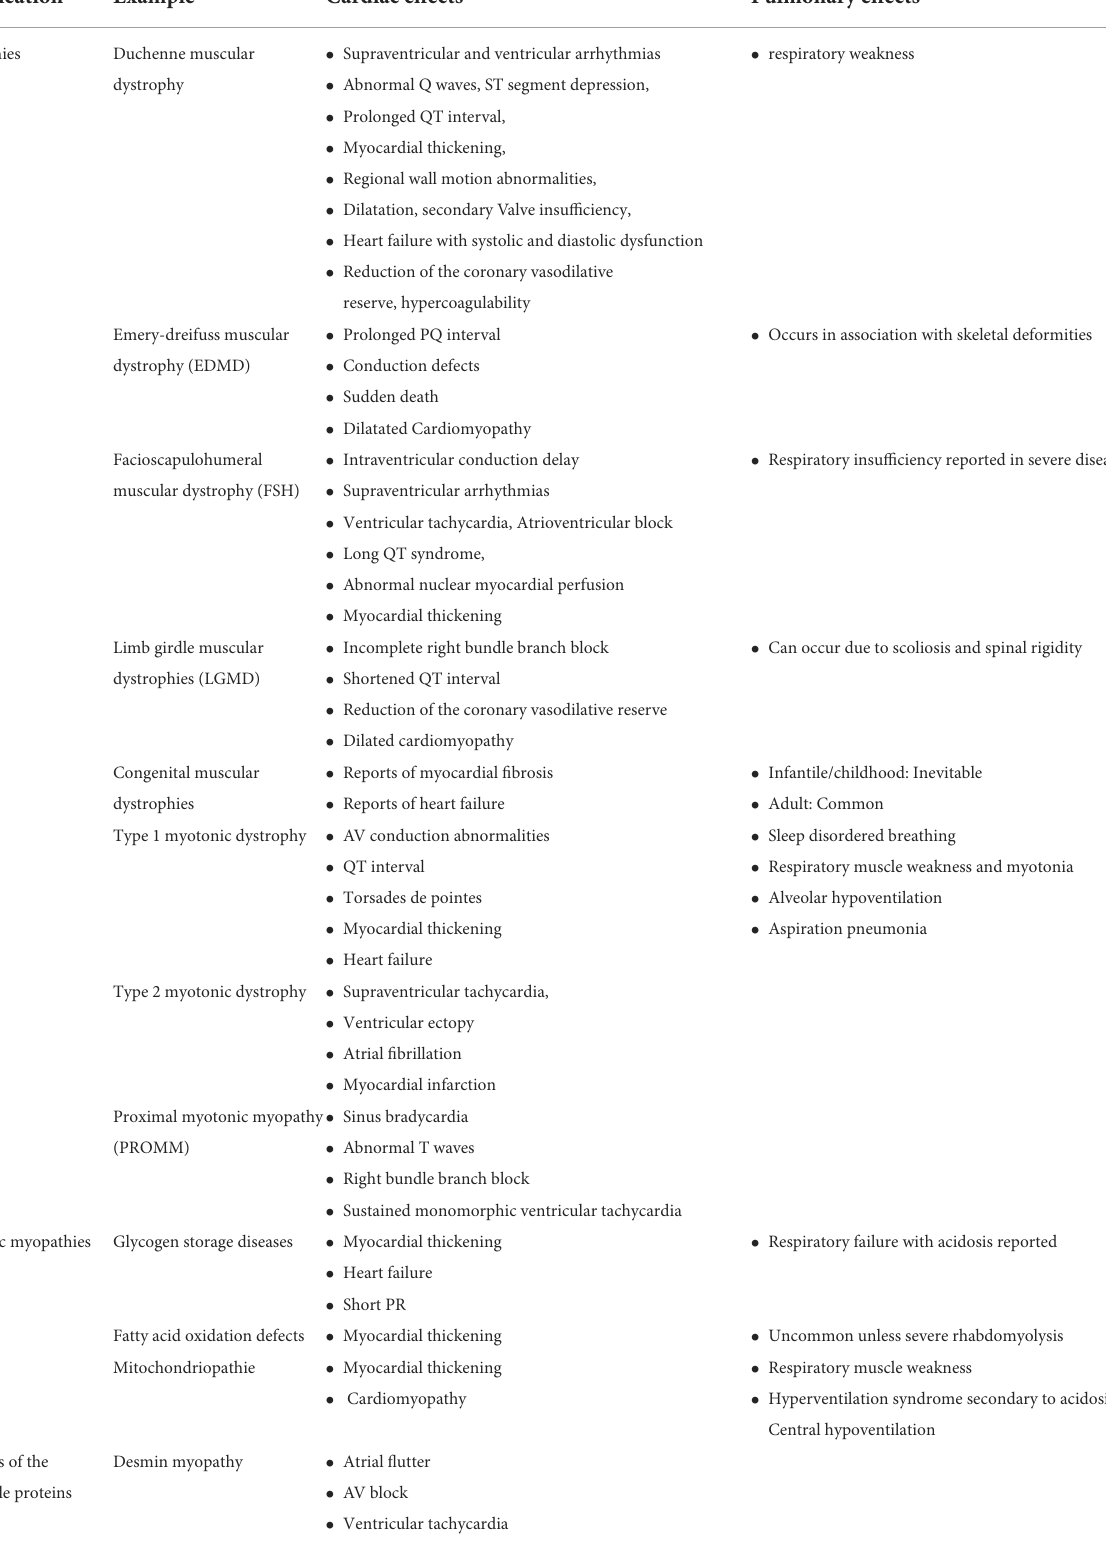
TABLE 1 Cardiac and pulmonary effects in different primary myopathies.